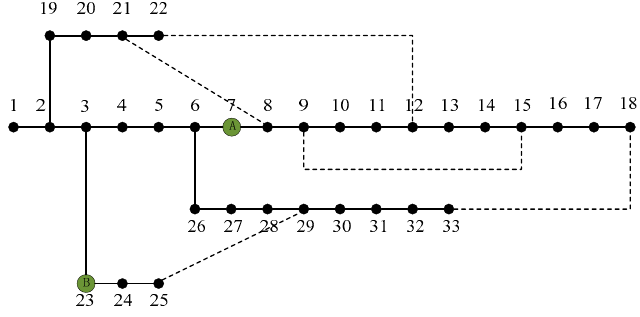
Figure 4. Structure of the IEEE-33 distribution system.